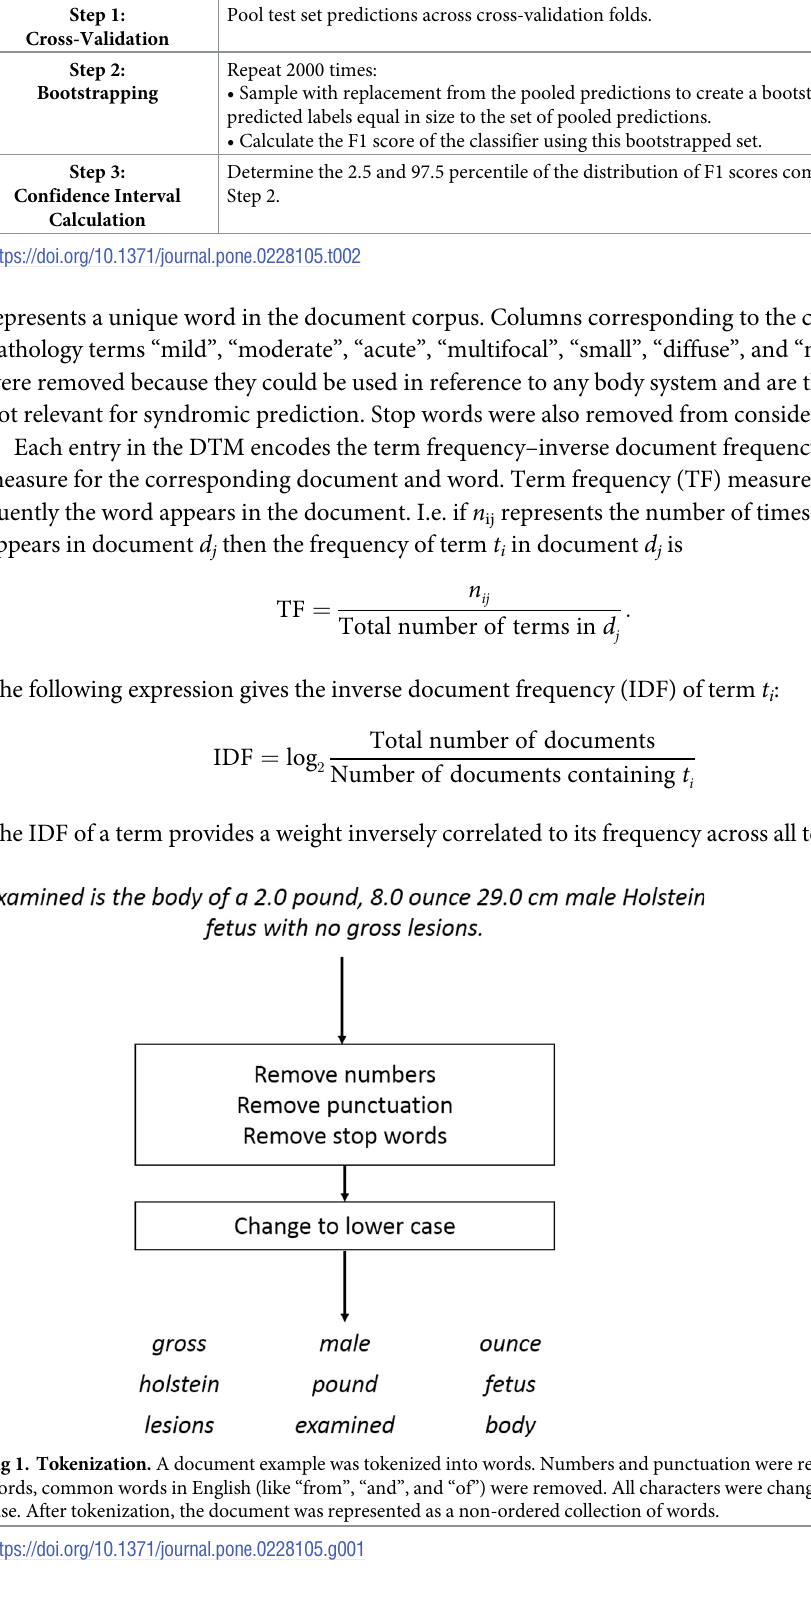
Table 2. Determining confidence intervals in cross-validation experiments. Step 1: Pool test set predictions across cross-validation folds. Cross-Validation